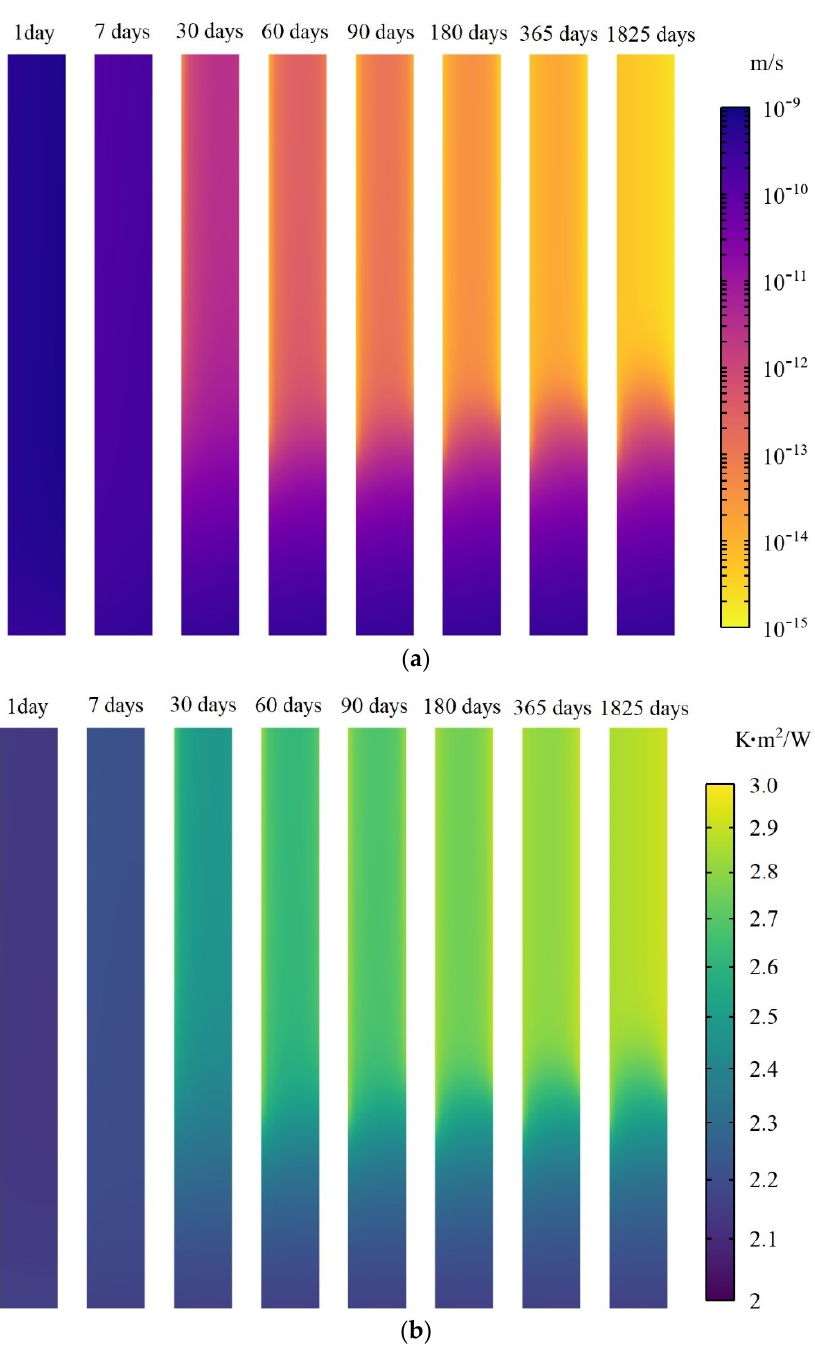
Figure 3. ( a ) . Distribution of hydraulic conductivity in the wall according to time. ( b ). Distribution of RSI value in the wall according to time.